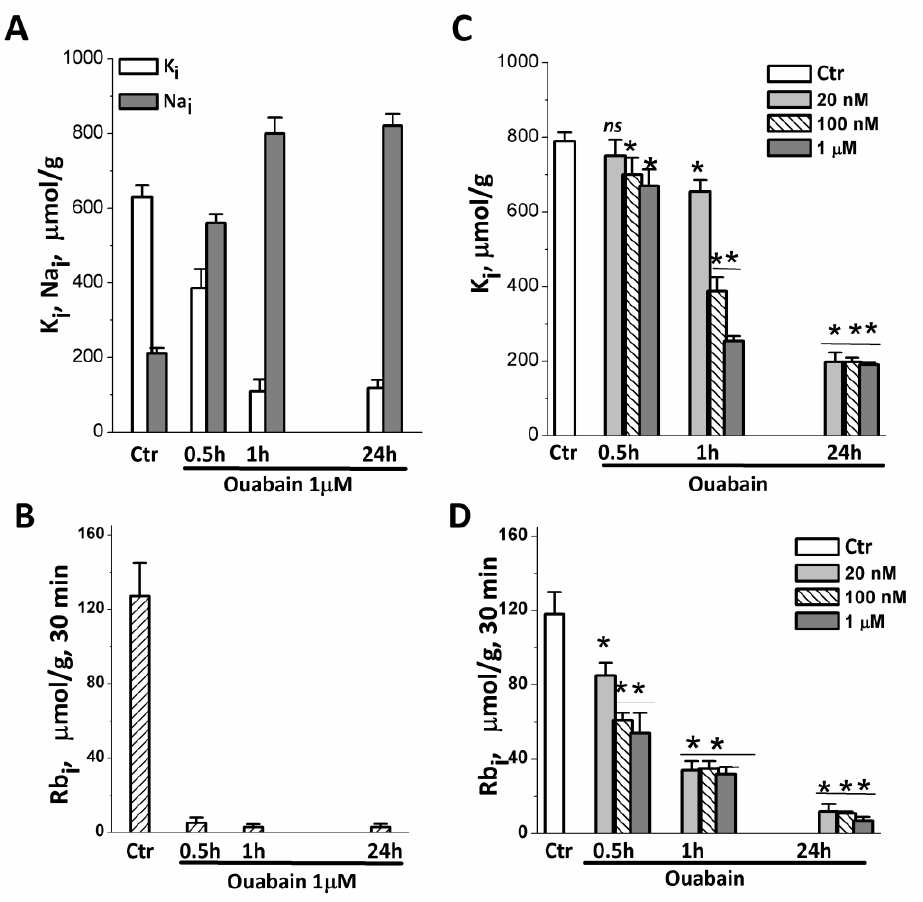
Figure 5. Changes in intracellular K + and Na + content and pump-mediated Rb + uptake in eMSCs growing in spheroids and a monolayer after treatment with ouabain. ( A , B ) Cells in spheroids were treated with 1 μM ouabain for 0.5, 1 and 24 h and analyzed for K + (black columbs), Na + (light columns) content ( A ), and Rb + uptake ( B ) by flame emission photometry. ( C , D ) Cells in monolayer were treated with 20, 100 nM, or 1 μM ouabain for 0.5, 1, and 24 h and analyzed for K + content ( C ) and Rb uptake ( D ). Data are shown as mean ± SD (n = 3) of one representative experiment from two performed on the same scheme. * p < 0.5, ** p < 0.05, *** p < 0.005 vs. the control cell, ns—insignificant. Ctr—control cells.